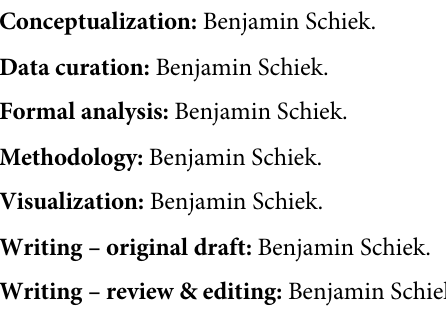
S1 Table. Securities appearing in the financial